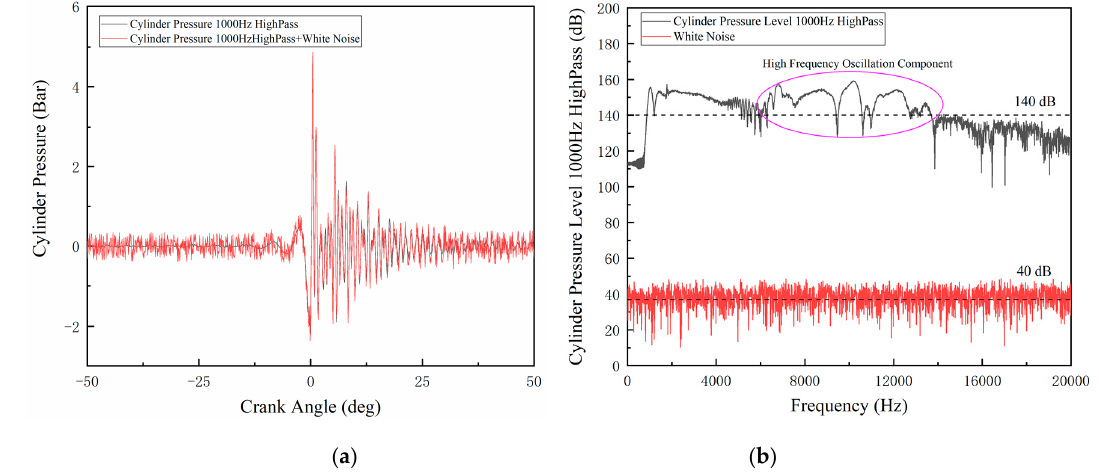
Figure 7. ( a ) Comparison chart of a 1000Hz high-pass filtered cylinder pressure signal and white noise in angle domain; ( b ) 1000Hz high-pass filtered cylinder pressure signal and white noise in the frequency domain.